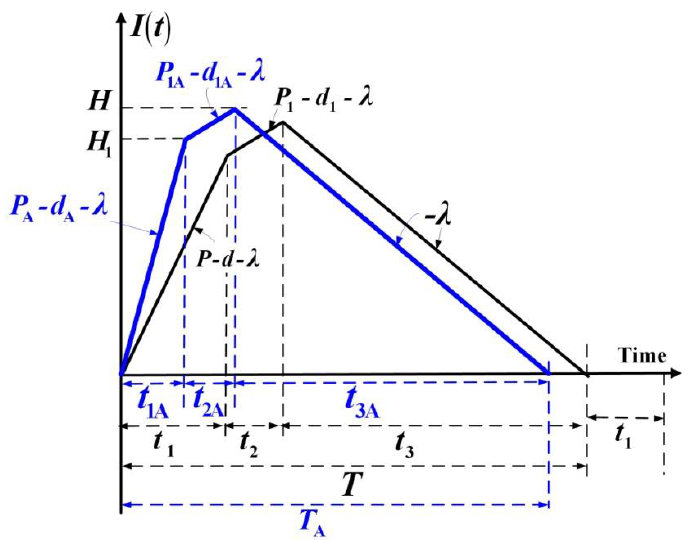
Figure 1. Level of on-hand inventories in the proposed EMQ-based system incorporating an expeditious production rate (in blue) as compared to that in conventional EMQ system (in black)